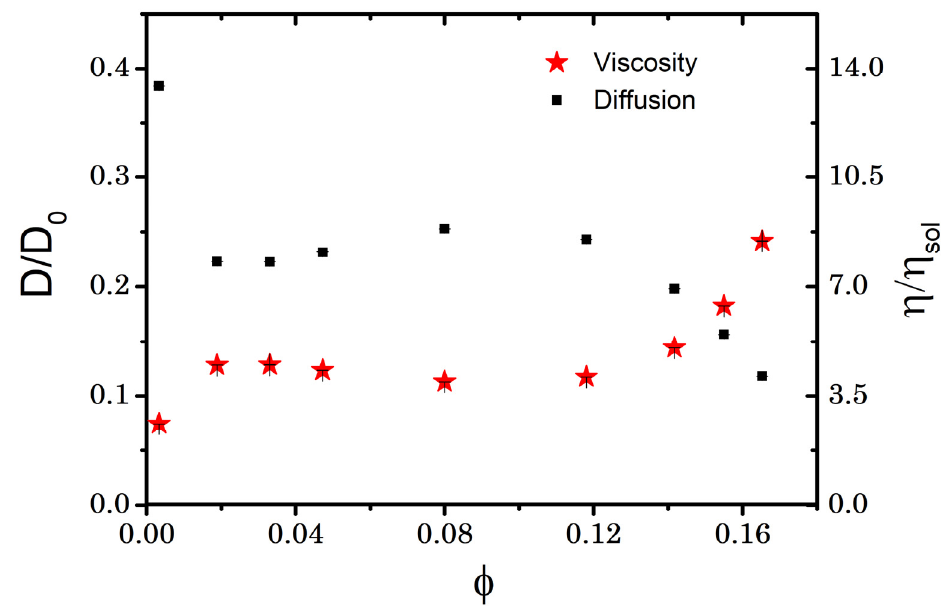
Figure 2 yields the prediction of the self-diffusion and viscosity.